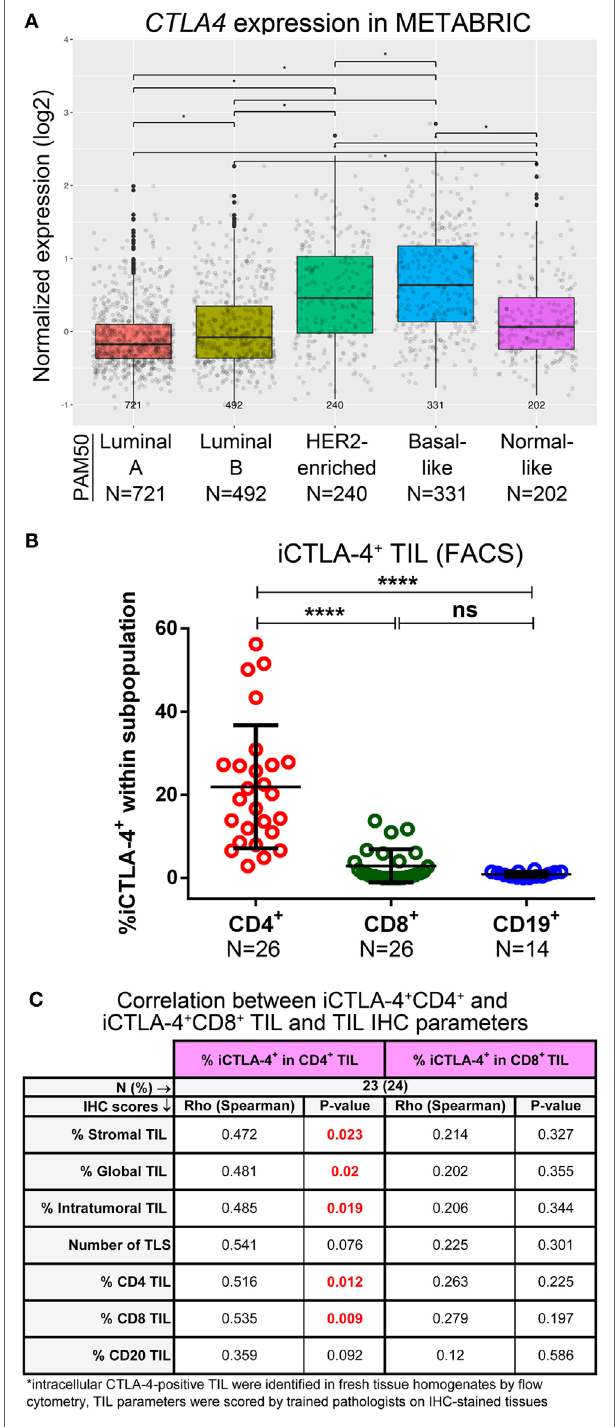
FigUre 4 | Continued Expression of CTLA-4 in primary breast cancer. (a) Expression of the CTLA4 gene by PAM50 molecular subtypes (microarray data from the METABRIC dataset) (37). Box plots show median ± interquartile range related to log of expression of CTLA4 gene in different subtypes (Luminal A, Luminal B, HER2-enriched, Basal-like, and Normal-like). (B) Intracellular CTLA-4 (iCTLA-4) expression by the major subsets (CD4 + , CD8 + , and CD19 + ) of tumor-infiltrating lymphocytes (TIL) isolated from fresh primary breast tumors analyzed by FACS. Bars show mean ± SD. The number of samples included ( N ) is based on the tumor homogenate having a threshold minimum number of TIL for analysis. (c) Correlations between the percentage of iCTLA-4 in CD4 + and CD8 + TIL (evaluated by FACS) and immune infiltration continuous parameters evaluated by immunohistochemistry